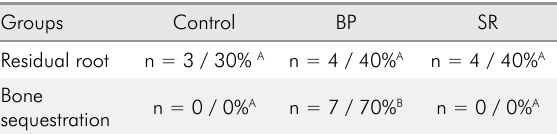
Table 2. Radiographic evaluation of the hemimandibles in C, BP, and SR groups.